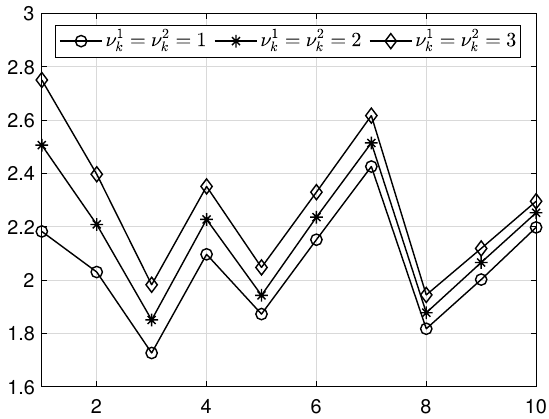
Figure 10. Average CPU times for various relaxation numbers on finest multigrid level ( ν 1 fixed relaxation numbers 1,2 and 3 on other grids with a 512